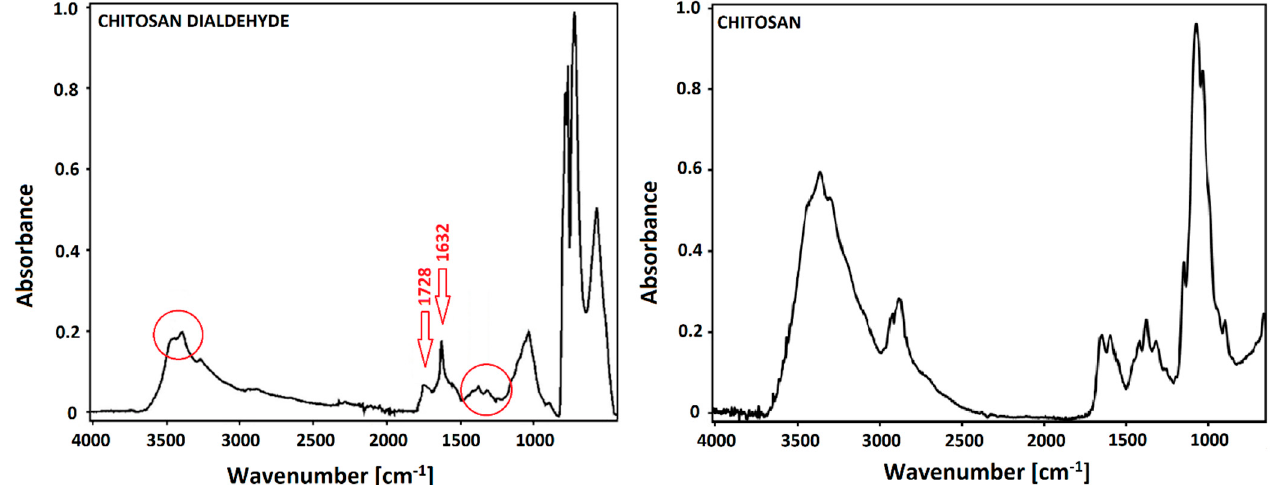
Figure 2. The Fourier transfer infrared spectroscopy with attenuated total reflectance device (FTIR-ATR) spectra of dialdehyde chitosan and chitosan.